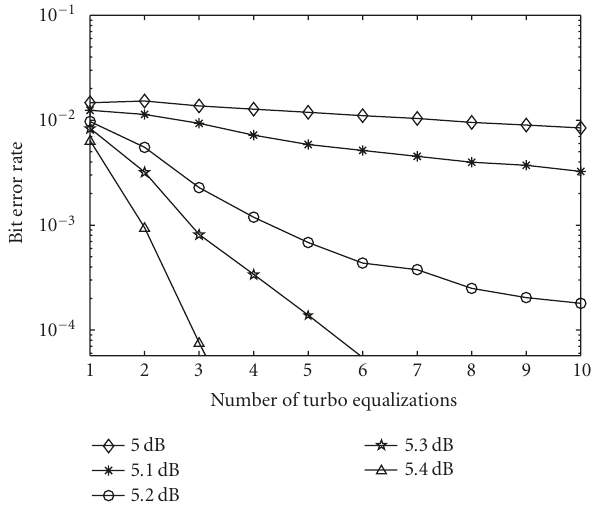
Figure 10: Performance improvement by employing turbo equal- ization, turbo coded